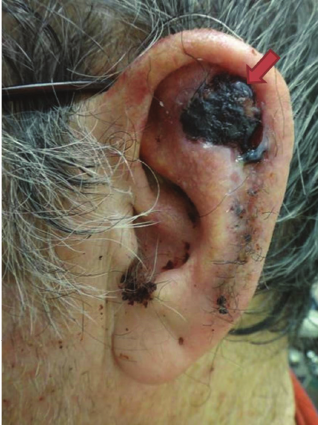
Figure 1: 76-year-old Caucasian man with a moderately differenti- ated squamous cell carcinoma covered by hemorrhagic crust on the left anterior upper ear (arrow).